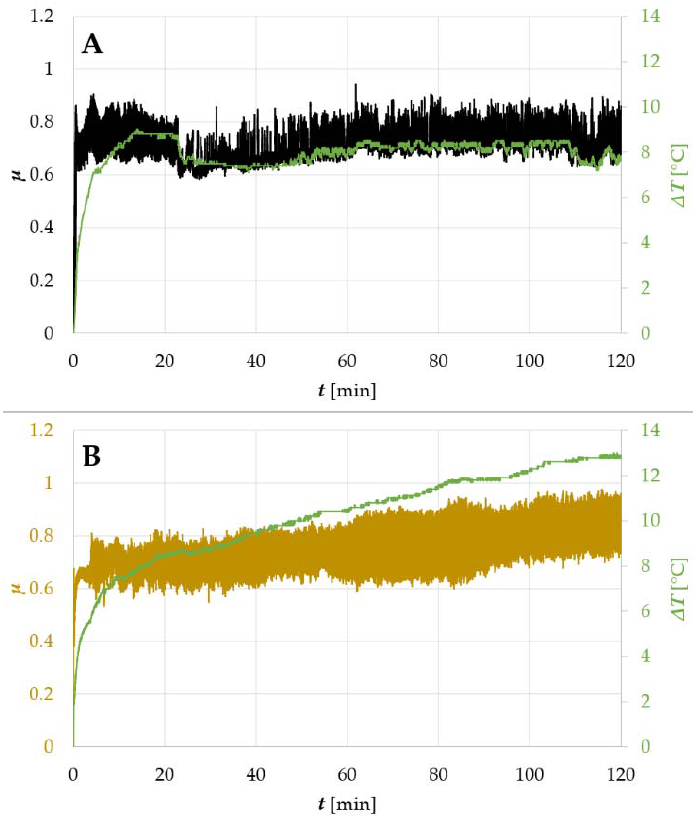
Figure 7. A comparison in frictional and thermal response of 440B stainless steel subjected to different surface finish: ( A ) uncoated sample (reference), ( B ) TiN-coated sample. surface finish: ( A ) uncoated sample (reference), ( B ) TiN-coated